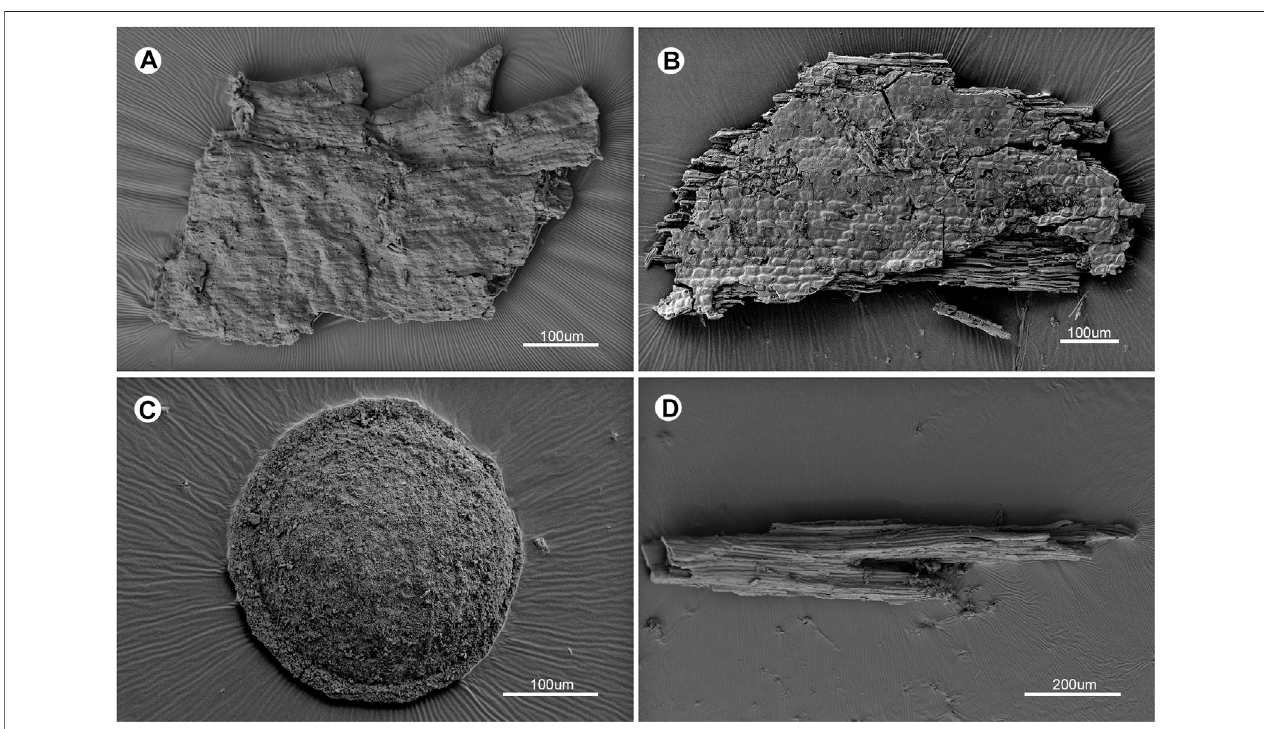
FIGURE 6 | SEM images of charred plant remains from clastic rocks of the Xuanwei Formation. (A) Charred leaf fragment shows serrated edge. (B) Charred epidermisofplantswithmoltencuticleandvasculartissue. (C) AccompanyingmegasporeacquiredfromclasticrocksoftheXuanweiFormation. (D) Charredtwigwitha